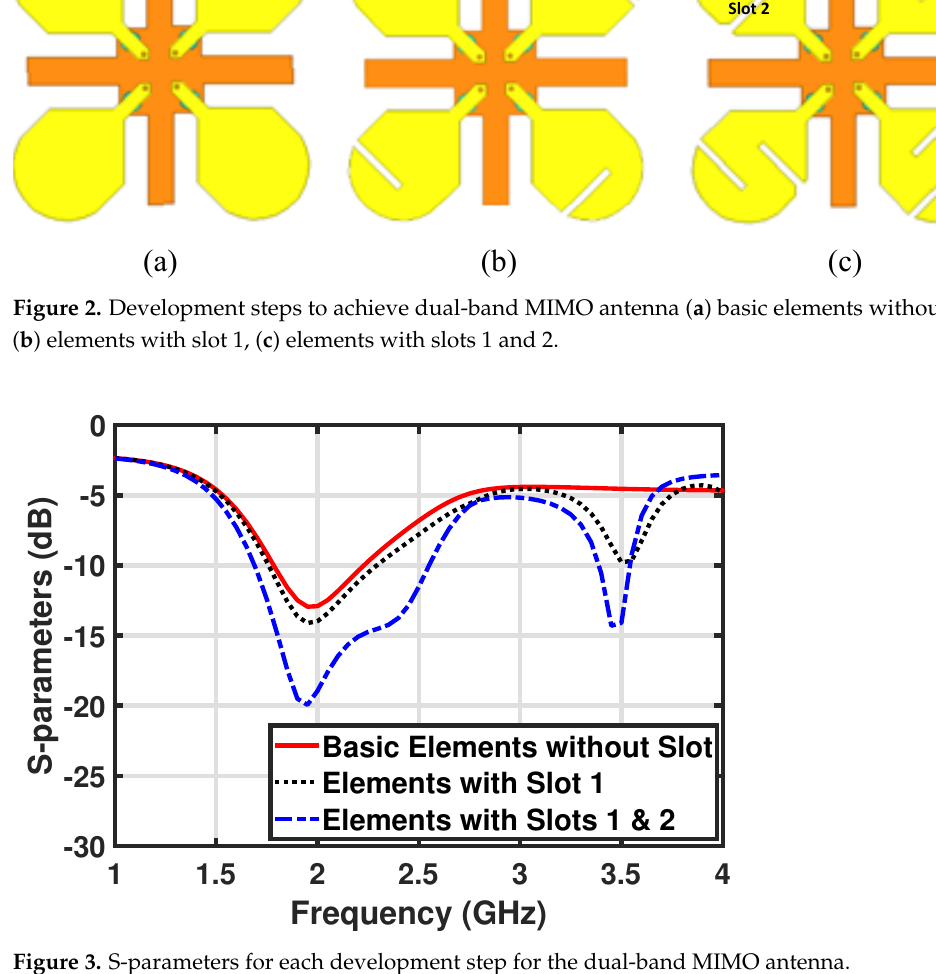
Figure 3. S-parameters for each development step for the dual-band MIMO antenna. The partial ground consisted of a plus-sign-shaped structure and played an important role in achieving a higher degree of isolation among all antenna elements. The width (Wg) of the ground structure was optimized to achieve higher isolation. A lower value of the Wg provided good isolation between the elements, and vice versa. The attained optimized value of Wg was equal to 5 mm. The optimized S-parameters for antenna 1 of the dual-band MIMO antenna are shown in Figure 4. All of the S-parameters of each antenna element were expected to be the same due to the symmetry of all antenna elements with respect to other elements, so the S-parameters for antenna 1 are shown here for brevity. The final optimized MIMO antenna covered dual frequency bands; the first band was a wide band of frequencies from 1550 to 2650 MHz, that covered 2G, 3G, 4G, and several 5G sub-6GHz bands, while the upper frequency band also covered the most common 3.5 GHz frequency band, 3350–3650 MHz, for 5G applications. All of the coupling S-parameters—S21, S31, and S41—remained below − 10 dB in the lower frequency band, while these were below − 19 dB for the higher frequency band, which is suitable for existing 2G, 3G, and 4G, as well as for upcoming 5G